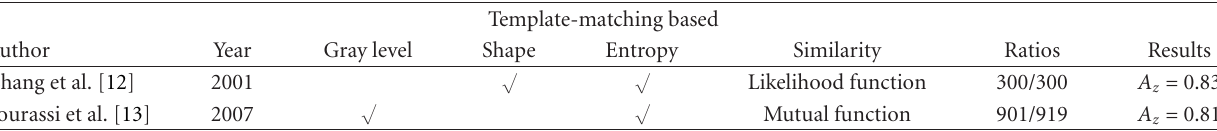
Table 2: Previously developed approaches on mass detection based on template matching. In this table, the ratio which indicates the number of real masses/number of normal